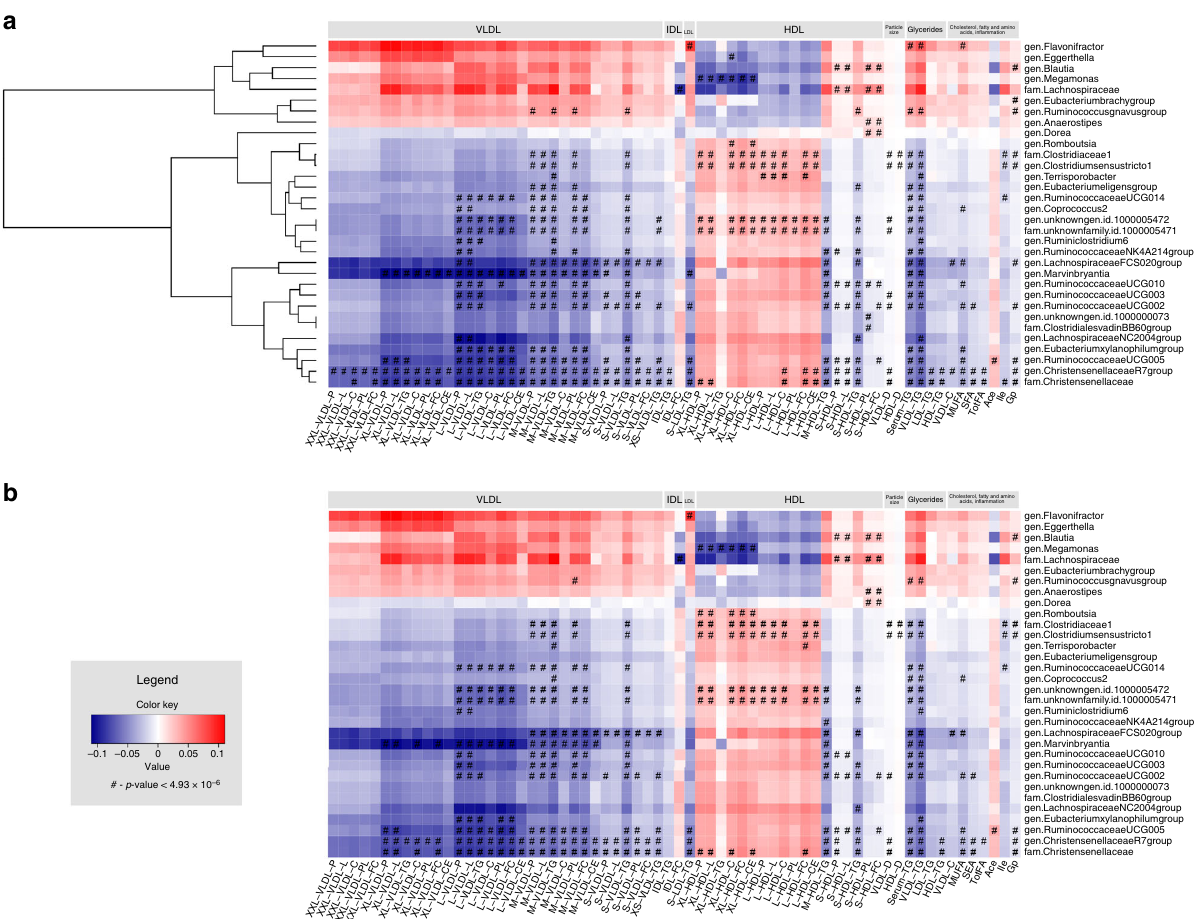
Fig. 1 Results of association analysis between metabolites and microbial genera and families assessed by linear regression analysis ( n = 2309). Association results after adjustment for age, sex, body mass index, technical covariates, and medication use are displayed on panel ( a ), while association results after additional adjustment for smoking and alcohol consumption are shown on panel ( b ). Metabolites are displayed on x -axis, whereas microbial genera and families are shown on y -axis. Lipoprotein classes include very-low-density lipoprotein particles (VLDL), intermediate lipoprotein particles (IDL), low-density lipoprotein particles (LDL), and high-density lipoprotein particles (HDL) of very low (XS), low (S), medium (M), large (L), very large (XL), and extremely large (XXL) size. Blue color stands for inverse association. Red color denotes positive associations. Symbols on the plot represent the level of signi fi cance with hash denoting Bonferroni signi fi cant associations at p value < 4.93 × 10 − 6 . Source data are provided as a Source Data fi